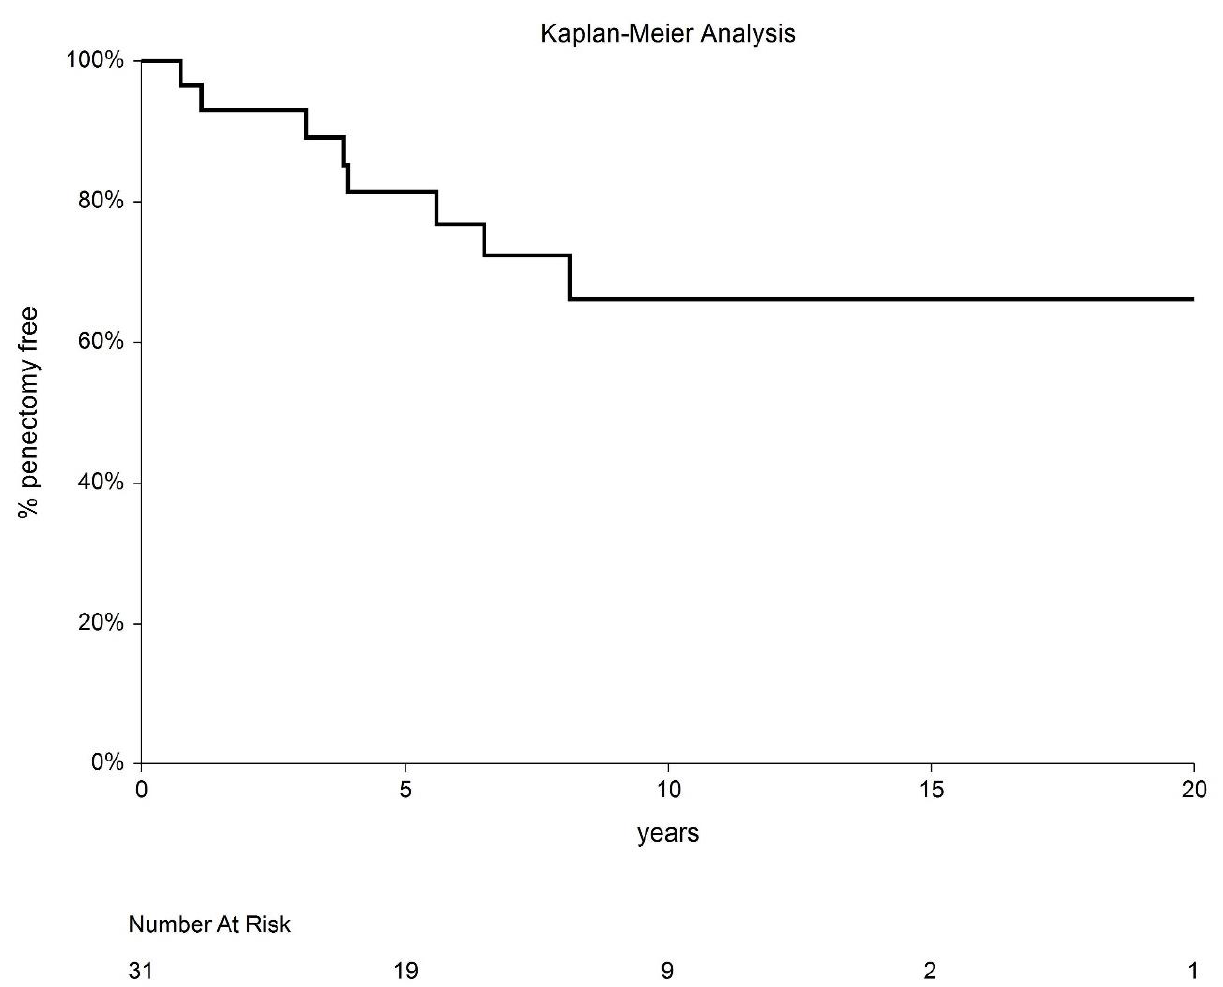
Figure 7. Penectomy-free interval outcomes.